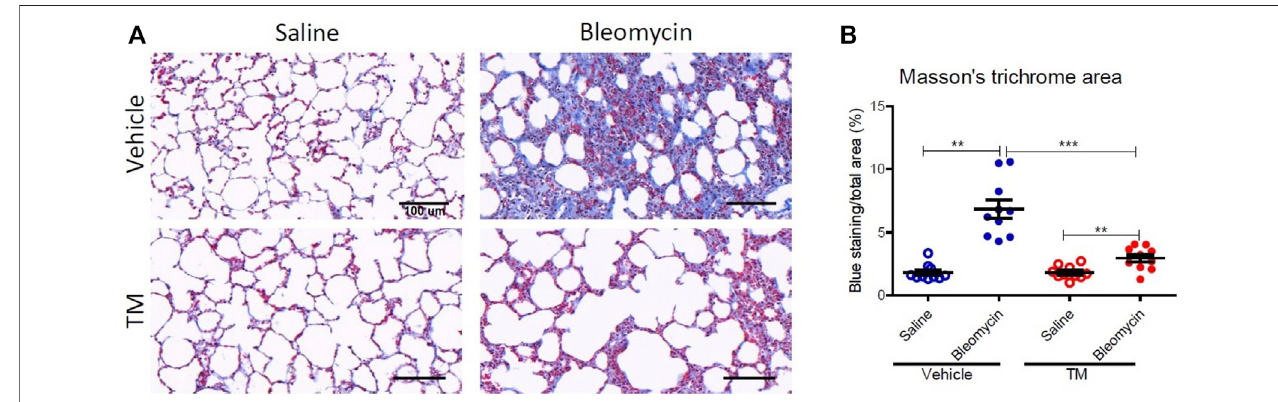
FIGURE8| Collagendepositionintheparenchymaofdifferentiallytreatedlungtissuesections. (A) RepresentativephotomicrographsofMasson ’ strichrome,blue- stainedhistologicaltissuesincontrolandbleomycinchallengedsegmentstreatedwitheitherTMorvehicle. (B) Graphsshowing fi broticfraction(Masson ’ strichromeblue staining area/total fi eld area) in differentially treated lung tissue sections. Signi fi cance was determined using a paired t -test between lung segments from the same treatmentgroupandanunpaired t -testbetweenlungsegmentsfromdifferentgroups,* *p < 0.01, ***p < 0.001.Datarepresentmean( ± SEM).Scalebars (cid:1) 100 µm.